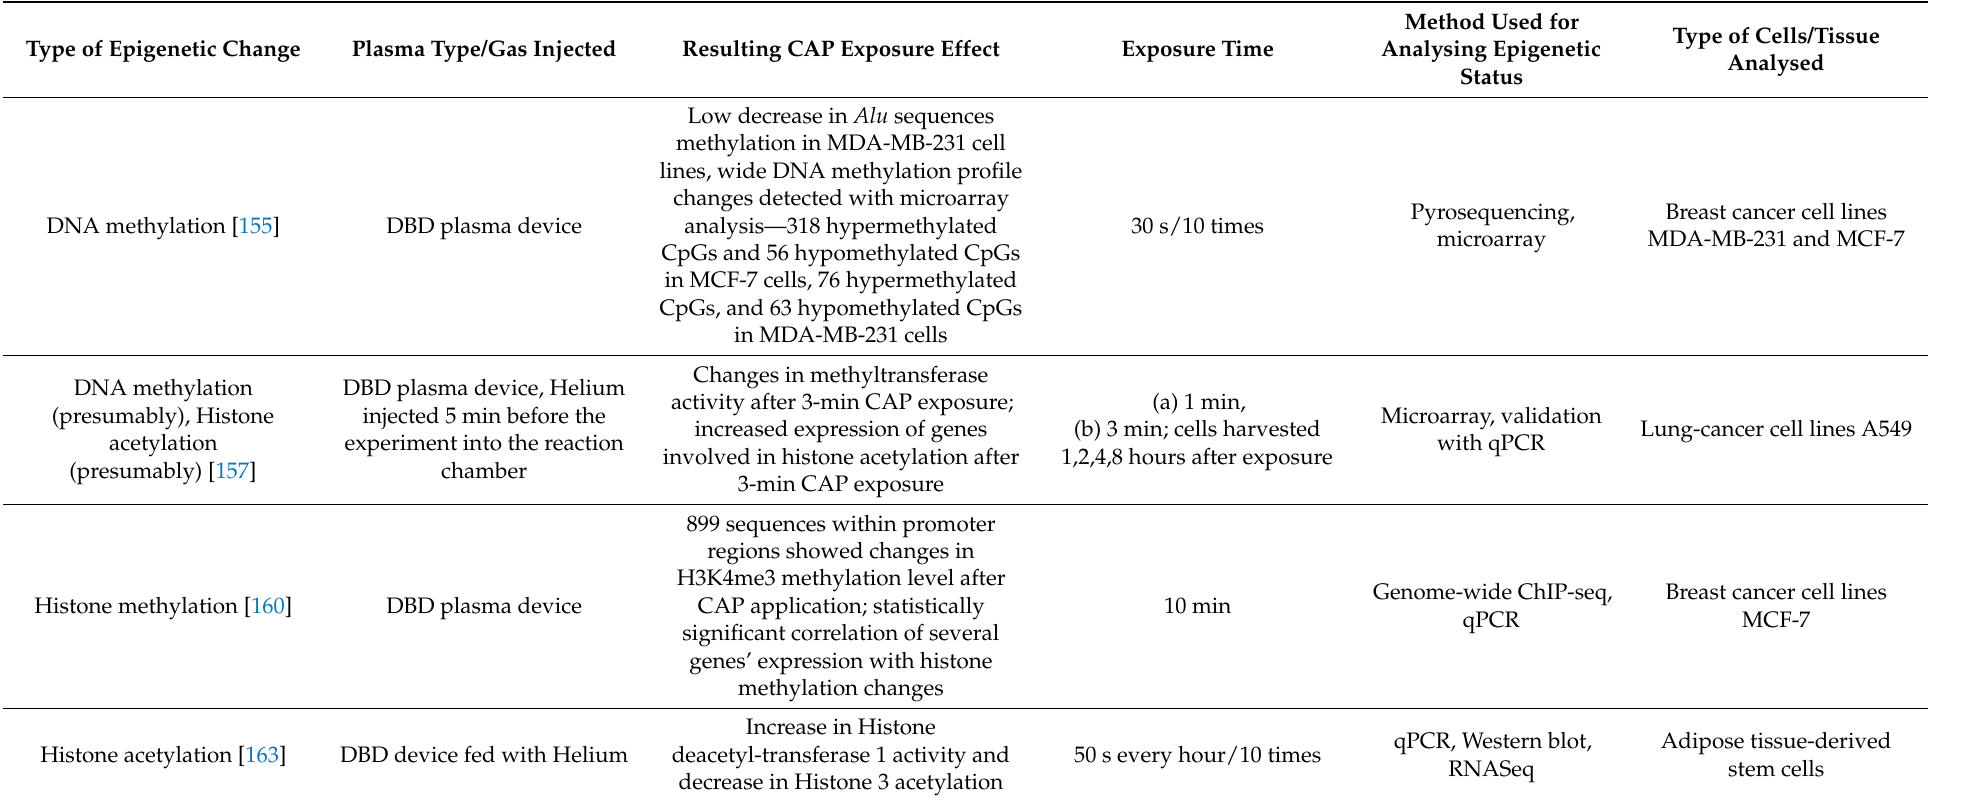
Table 1. List of CAP effects on epigenetic changes and non-coding RNA expression and